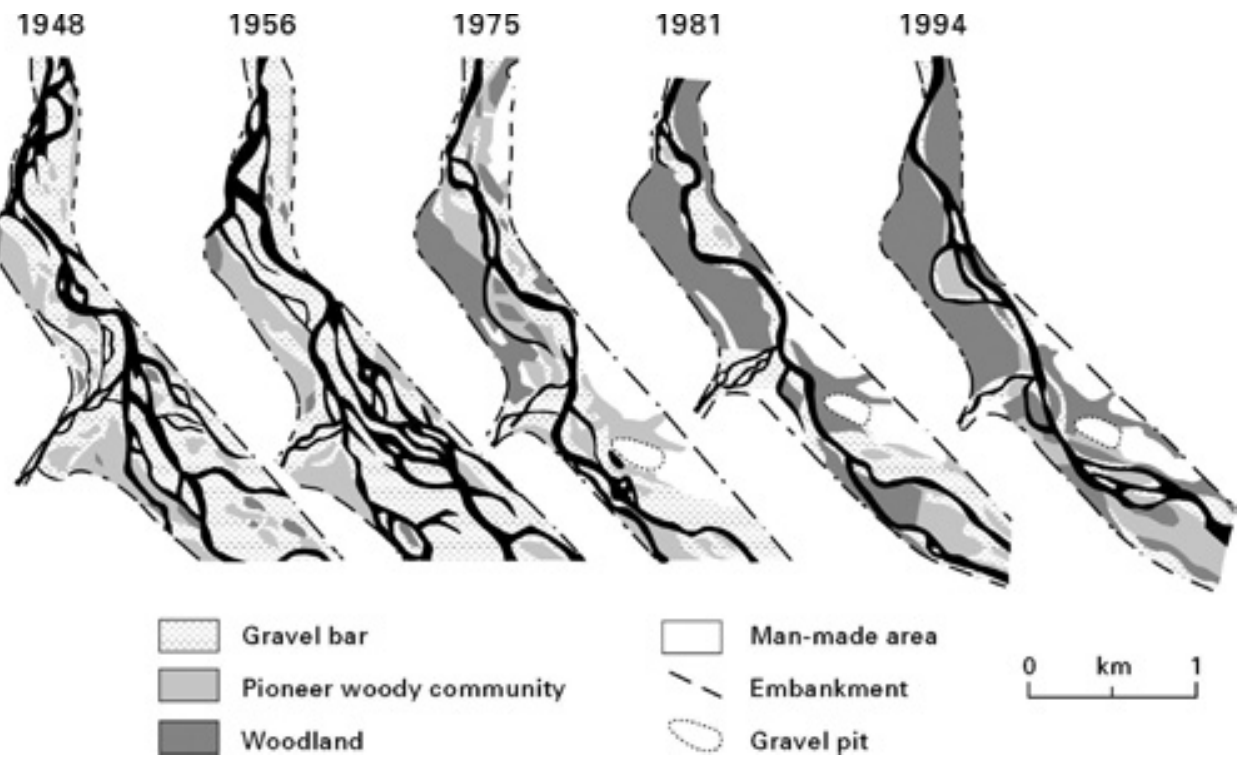
Fig. 4. Between 1948 and 1994, the River Drac in France changed from a wide, braided floodplain dominated by gravel bars to a narrower, less mobile floodplain dominated by mature woodland. Change to this floodplain was caused by gravel extraction and dam construction, which together caused channel incision and alterations to the hydrograph (Redrawn from Pautou et al.